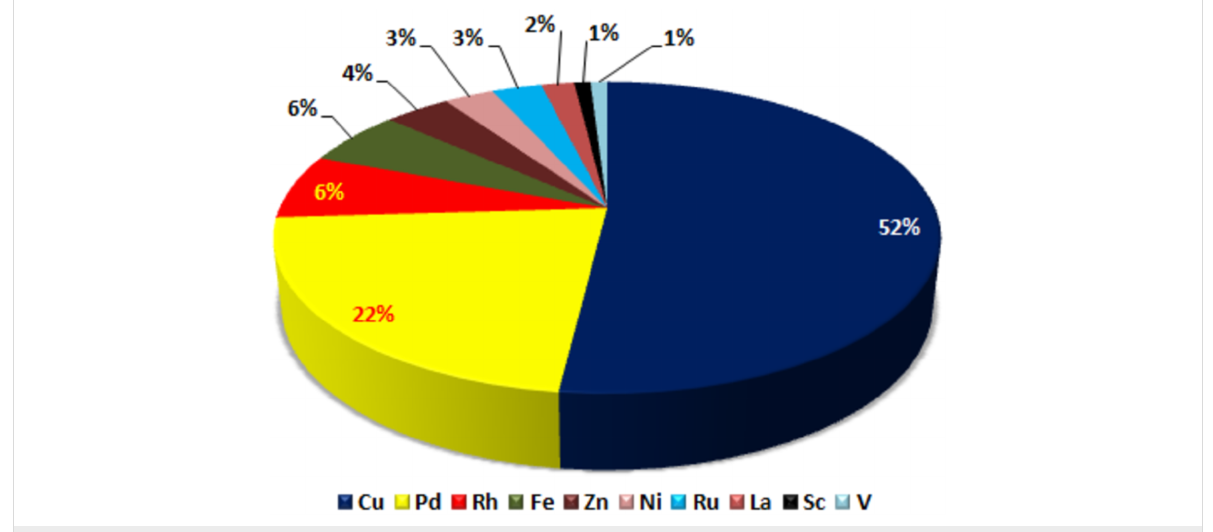
Figure 2: Participation percentage of various TMs for the syntheses of